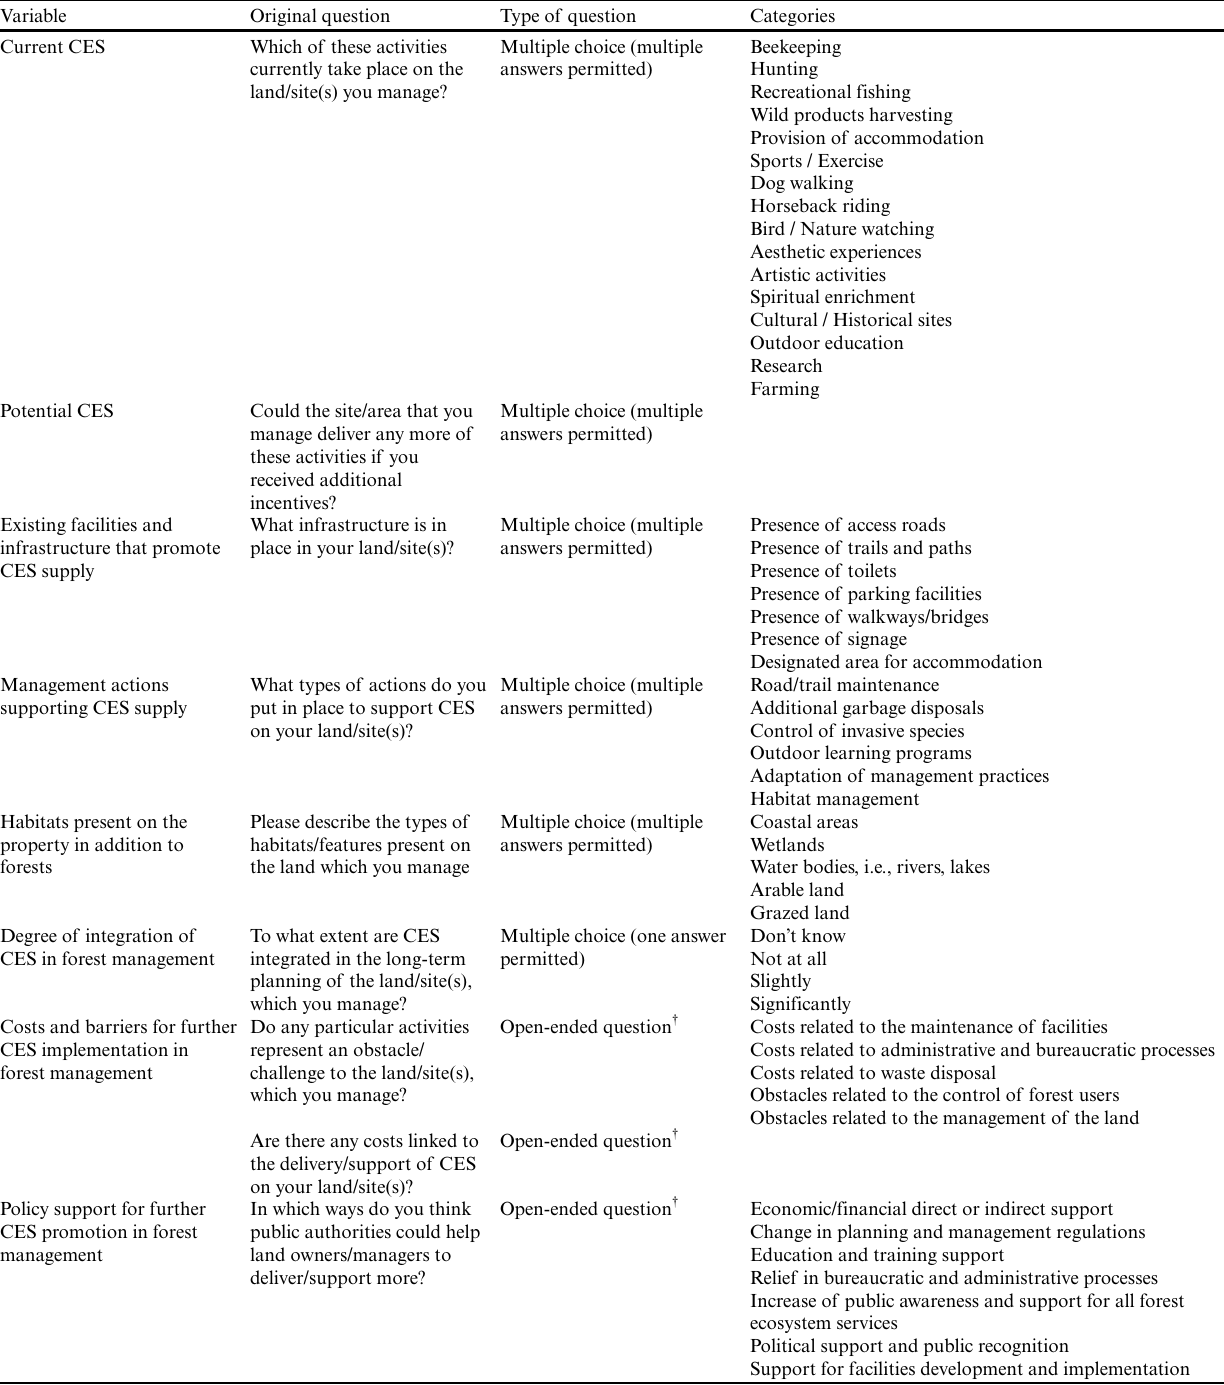
Table 1 . Variables and categories analyzed from the survey. CES = cultural ecosystem